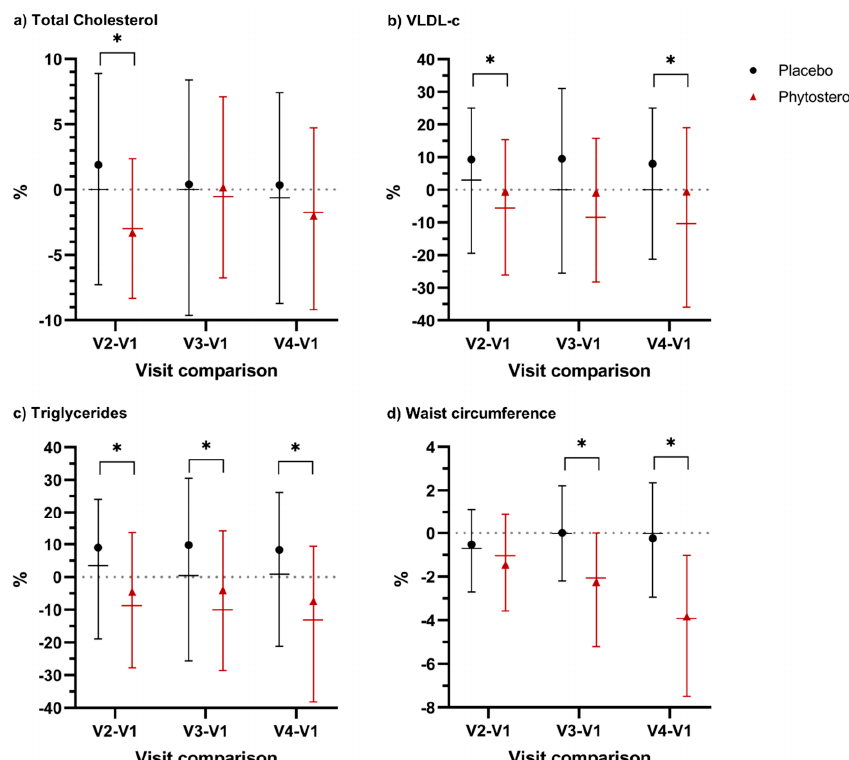
Figure 4. Relative difference (%) between V2 and V1, V3 and V1 and V4 and V1 for ( a ) total cholesterol; ( b ) very-low-density lipoprotein cholesterol (VLDL-c); ( c ) triglycerides; ( d ) waist circumference by the group. * Statistically significant ( p < 0.05). Black lines represent the placebo group, and red lines the phytosterol group. Horizontal lines represent the interquartile range and the median. Black points (•) represent the mean for the placebo group, and red triangles ( ▲ ) represent the mean for the phytosterol group.